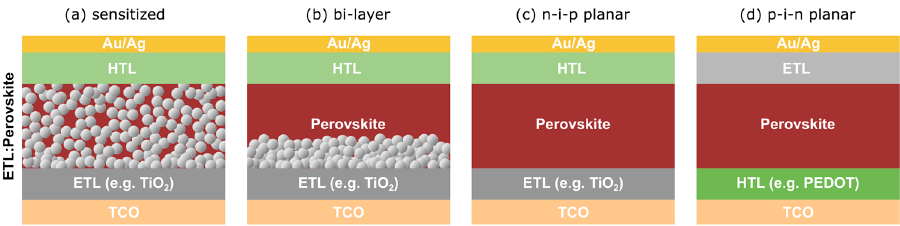
Figure 2. Various device architectures for organometal trihalide perovskite solar cells. ( a ) Mesoporous sensitized, ( b ) bi-layer, ( c ) n-i-p planar and ( d ) p-i-n planar. ETL, HTL, and TCO stand for electron transport layer, hole transport layer, and transparent conducting oxide, respectively.